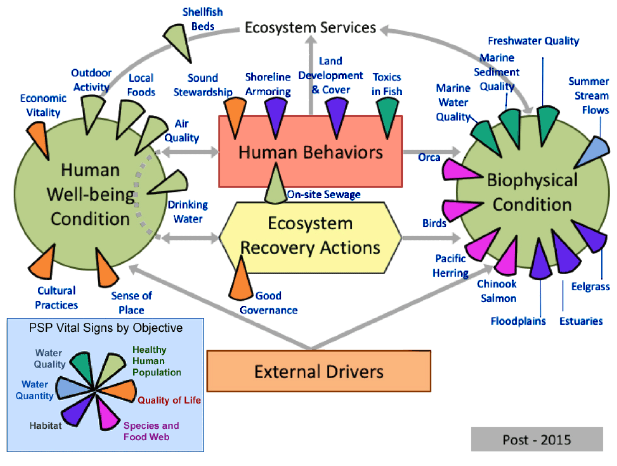
Fig. 4 . Final representation of Puget Sound vital signs, including more direct metrics associated with human well- being. PSP, Puget Sound